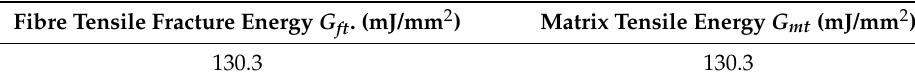
Table 11. Fracture toughness of auxetic